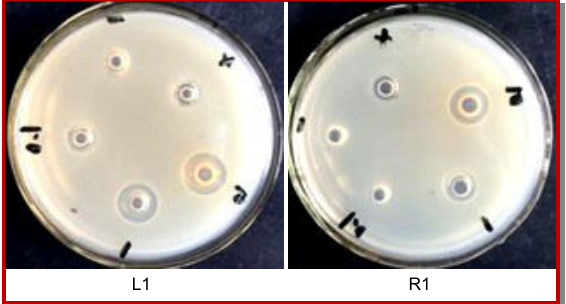
L1 Figure 1: Inhibitory effect of crude extracts of endophytic strains L1 and R1 on S. aureus Negative control (DMSO); +: positive control (ampicillin sodium); 10, 1, 0.1: concentration of crude EtOAc extract (mg/mL)